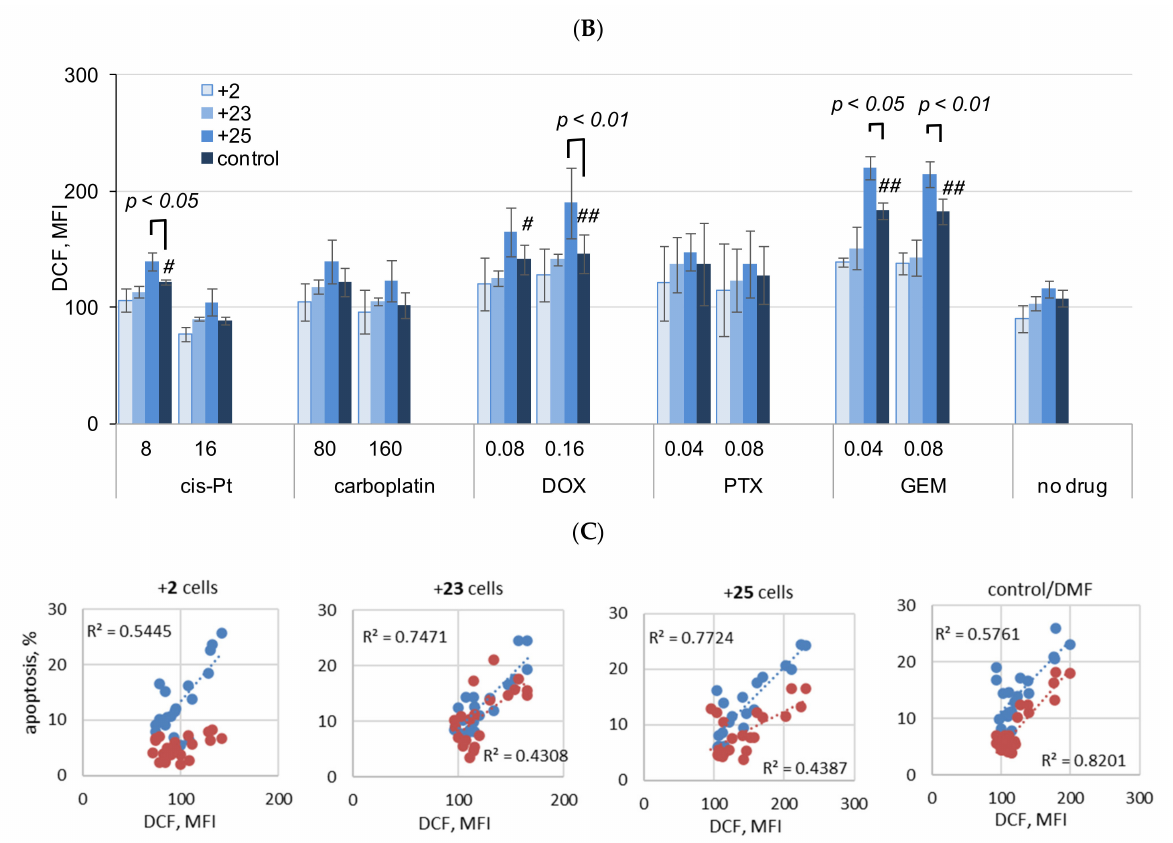
Figure 9. Apoptosis and necrosis ( A ), and ROS production ( B ) in A2780cisR cells cultured long-term in medium with the addition of compounds 23 , 2 , or 25 , and then exposed to low and high concentrations of drugs, cisplatin, carboplatin, DOX, × IC50). Relationship of apoptosis to ROS production in cells cultured with the compounds, PTX, or GEM (at IC50 and 1 2 and the control cells, cultured without the compounds is shown in ( C ). Cell death was determined in terms of necrosis and apoptosis of cells stained with PI and annexin V-FITC. Double-stained cells were analyzed by flow cytometry as described in the Materials and Methods (Section 4). Cumulative percentage of necrotic/nonapoptotic (PI+/annexin V − ), late apoptosis (annexin V+/PI+), and early apoptosis (annexin V+/PI − ) cells is shown; ( A ) left—lower doses, ( A ) right—higher doses of drugs; “control”—cells cultured without compounds, with vehicle (DMF < 0.08%, not toxic). The mean ± SEM of three experiments are shown. p values (* p < 0.05 and ** p < 0.01) were calculated for nonapoptotic cells cultured with compound versus without compound; Student t-test with Bonferroni correction. Detailed statistical analysis is presented in the Supplementary Materials. Intracellular ROS production was measured by flow cytometry in DCF-DA stained cells (MFI, median intensity of fluorescence). The mean ± SEM of three experiments are shown in ( B ). p values were calculated by the Student t-test, cells cultured with compound versus without compound; # p < 0.05, ## p < 0.01 drug versus no drug. Symbols “+25”, “+2”, and “+25” stand cells cultured with addition of the respective compound, 25 , 2 , or 25 to culture medium. ( C ) Blue dots—early apoptosis (annexin V-positive/PI-negative cells), red dots—late apoptosis (annexin V and PI positive cells); data for A2780cisR cells treated with cisplatin, carboplatin, DOX, PTX, GEM, and cells without drugs were collected and analyzed; R 2 , Pearson correlation coefficient values. Cisplatin (8 µ M), DOX (0.08 µ M and 0.16 µ M), or GEM (0.04 µ M and 0.08 µ M) induced cellular ROS production in the cells not treated with the compounds (control/DMF, Figure 9B). In all cases, ROS production increased in the cells exposed to the drugs, cultured previously with compound 25